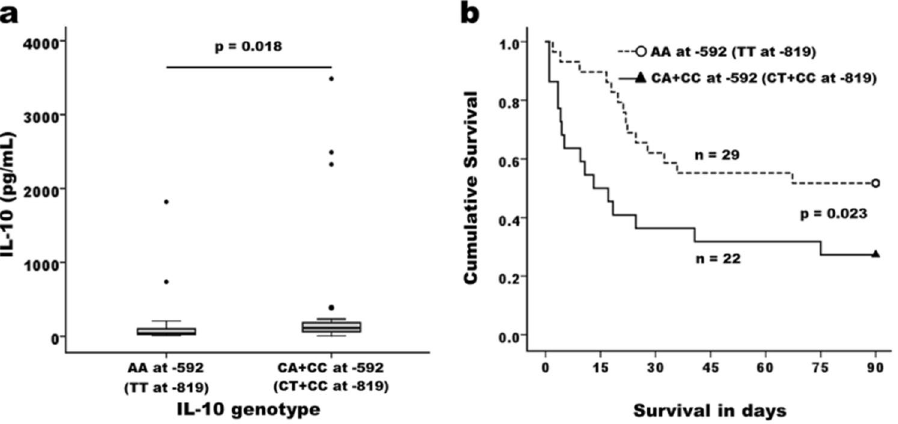
Figure 5. Effect of IL-10 genotypes on the initial plasma IL-10 concentrations and the 90-day survival probability after receiving ECMO support. ARDS patients with − 592 AC and CC ( − 819 TC and CC) genotypes were associated with higher plasma IL-10 level ( a ) and had significantly worse survival after ECMO support ( b